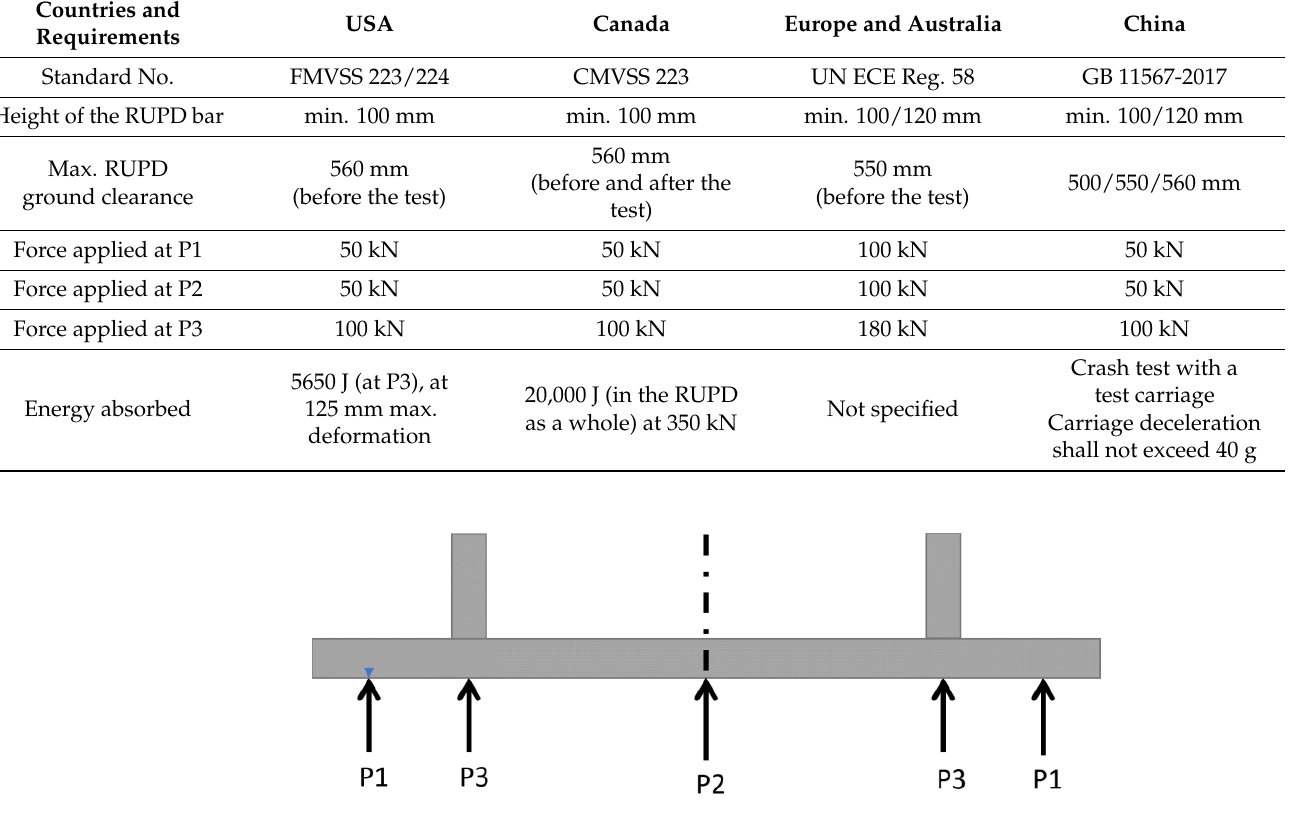
Figure 1. Schematic diagram of positioning the force application points during the RUPD strength tests.